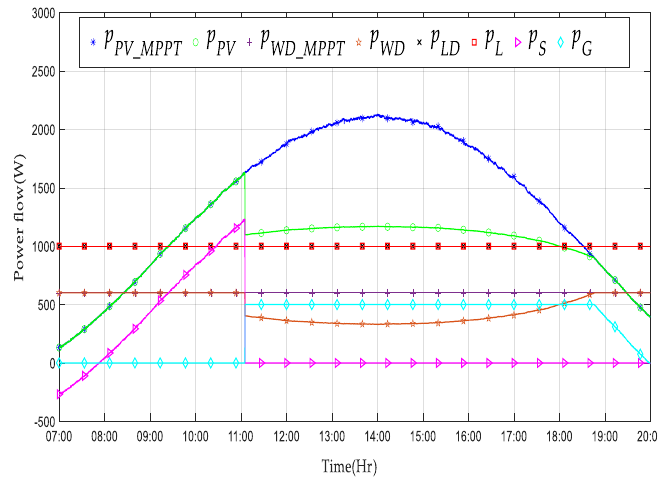
k , k , and soc without optimization by applying the  coefficient. D _ D real